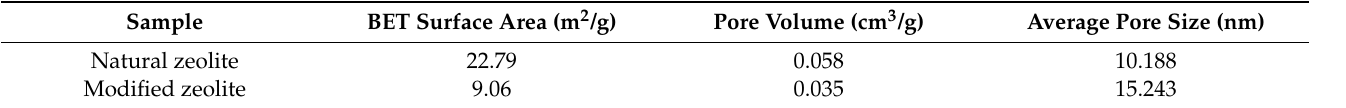
Table 3. The surface properties of natural and modified zeolite.